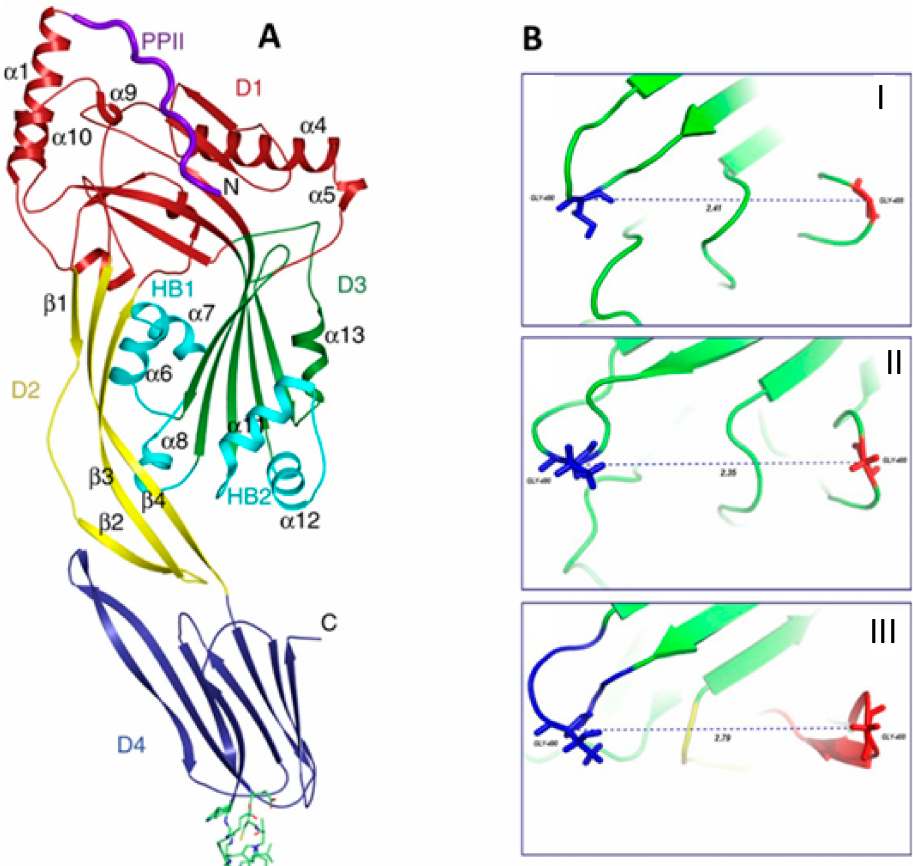
Figure 4. Molecular modeling of binding mechanisms of cholesterol (CHO) to listeriolysin O (LLO) and the effects of fisetin (FSN) on such binding. ( A ) LLO is organized into four domains (D1-D4). ( B ) I–III, Comparison of the distances (in nm) between the C α atoms of Gly490 and Gly400 is shown in the structures of free LLO (I), the LLO–CHO complex (II), and the LLO–FSN complex (III). The average distance of the LLO–CHO complex is 2.35 nm. In the absence of ligand, the average distance between the defined points is 2.41 nm, and in the LLO–FSN complex, the distance is 2.79 nm. Adapted from [99], J. Infect. Dis. 2015.